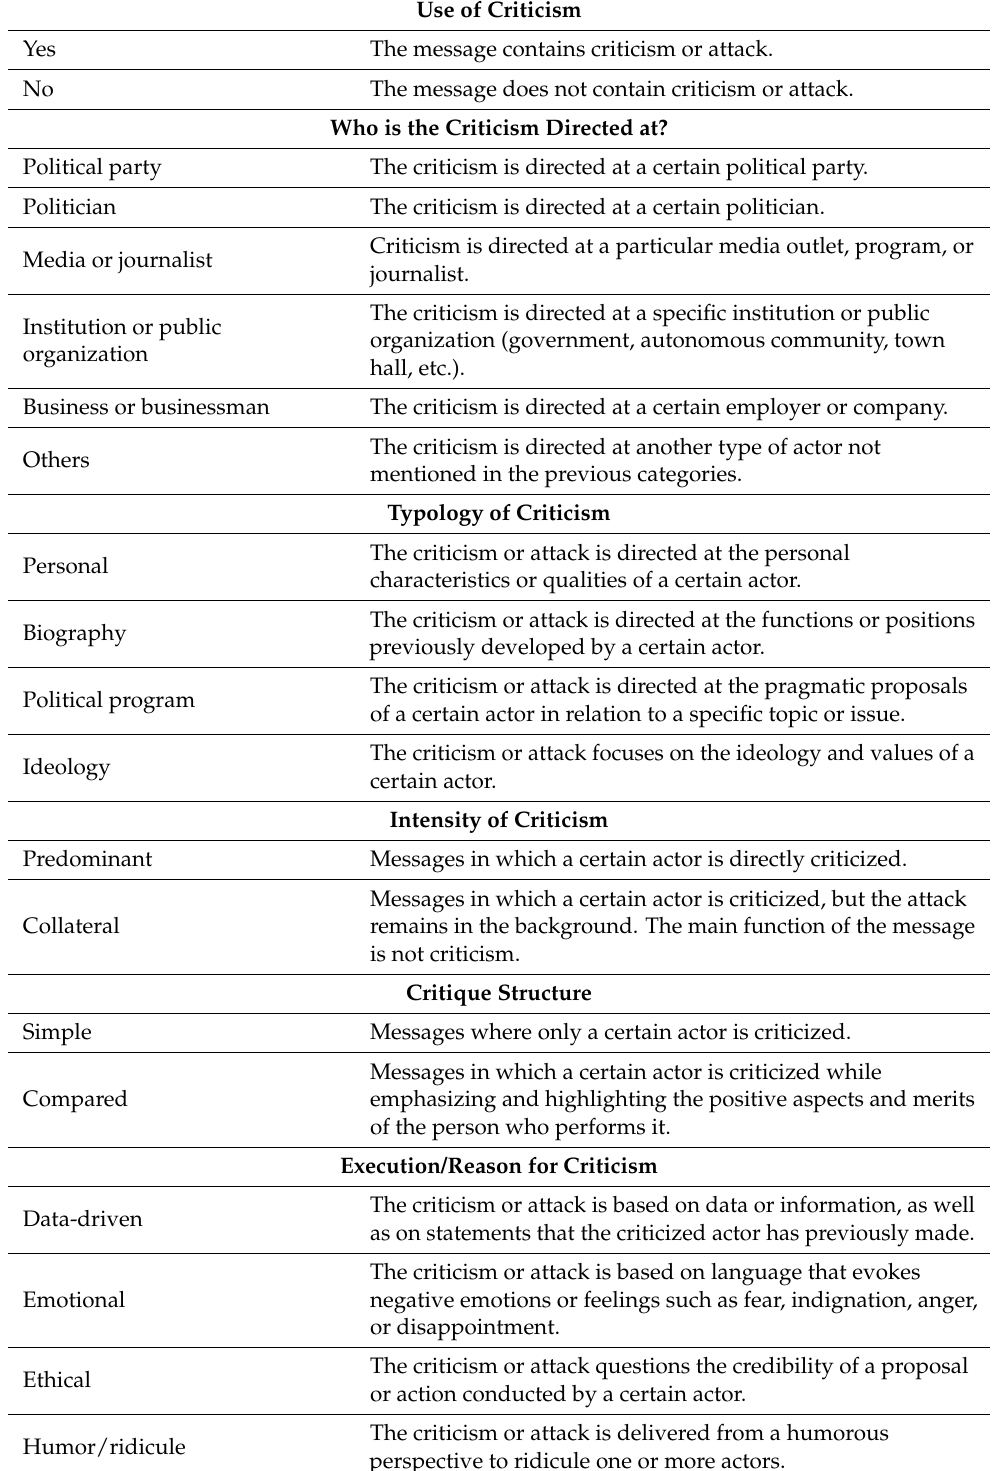
Table 2. Summary of the analysis model used in this